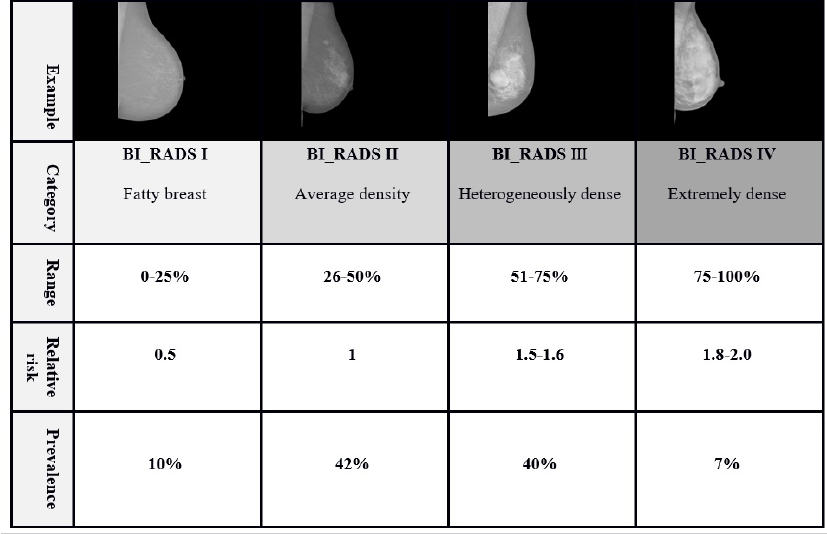
Figure 1. Prevalence, relative risks of developing breast cancer based on Four classes of Breast Imaging and Reporting Data ystem (BI-RADS) density standard (i.e., fatty, scattered fibroglandular density, heterogeneously dense, and extremely